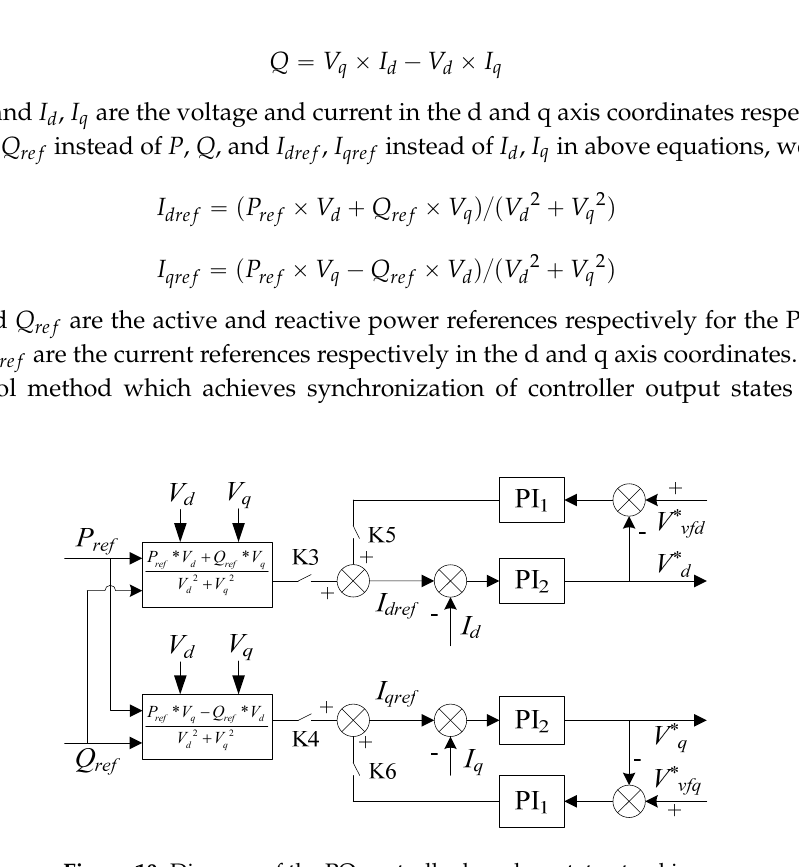
Figure 10. Diagram of the PQ controller based on status tracking.